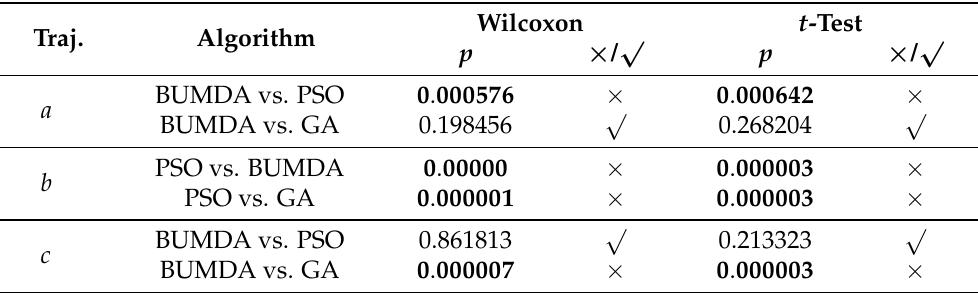
Table 3. p -values and acceptance/rejection of the null hypothesis of the Wilcoxon rank sum test and the t -test. × indicates that the left algorithm is better than the right one, while is not a significant difference between